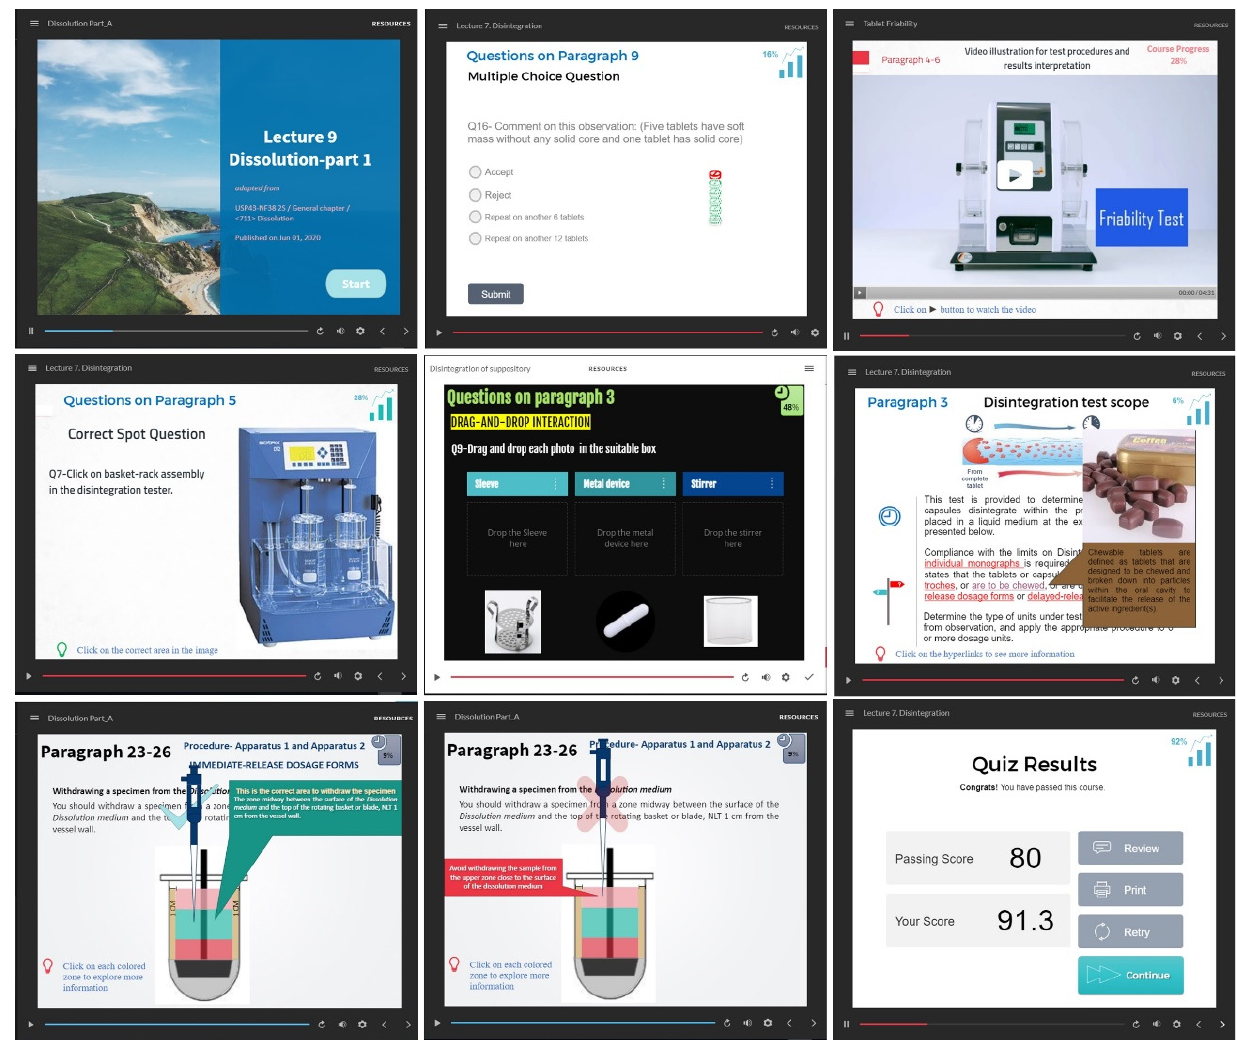
Figure 2. Captured screenshots of the e-lecture (iFEEL) slides.